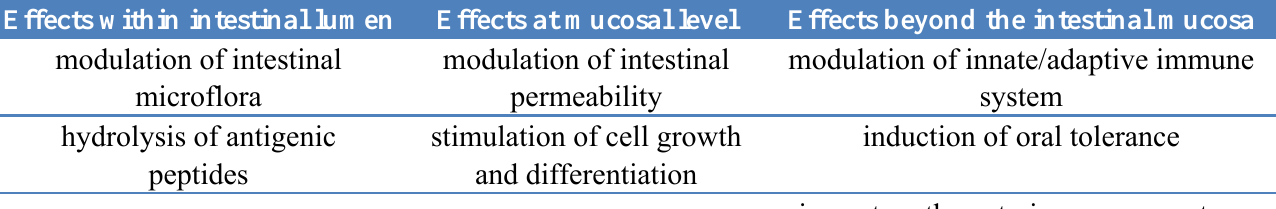
Table 1. Schematic representation of the potential mechanisms of action of probiotics in children with cow’s milk